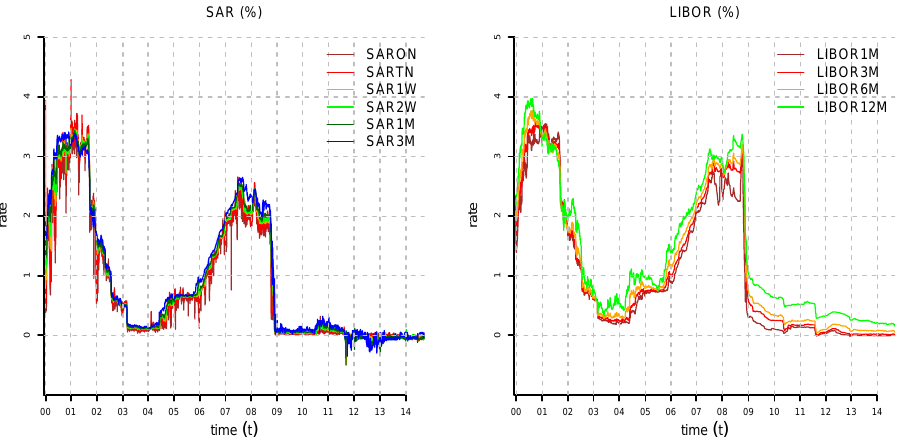
Figure 1. Yield rates (lhs): Swiss Average Rate (SAR) and (rhs) London InterBank Offered Rate (LIBOR) from 8 December 1999, until 15 September 2014. SWCNB (%)